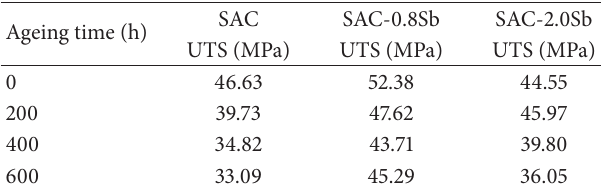
Table 1: Tensile strength of Sn3.5Ag0.7Cu- x Sb